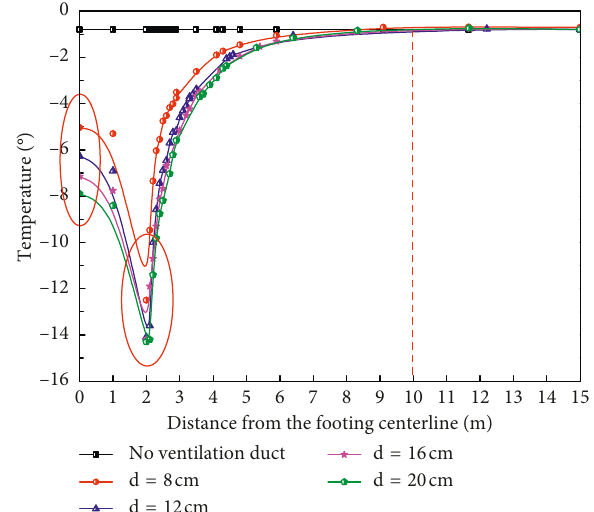
Figure 7: Annual mean temperature in footing centrelines on January